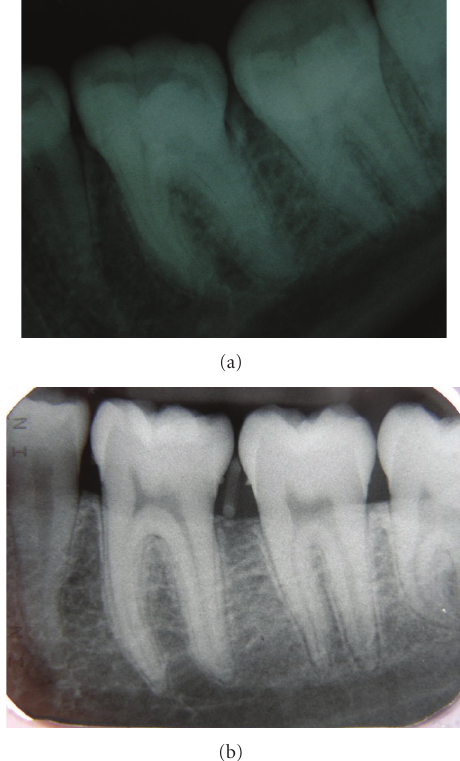
Figure 2: (a) Radiographic view of the elastic rubber band between the first and second lower left molars. (b) A proper periapical X-ray revealing an elastic band in the periodontal space.